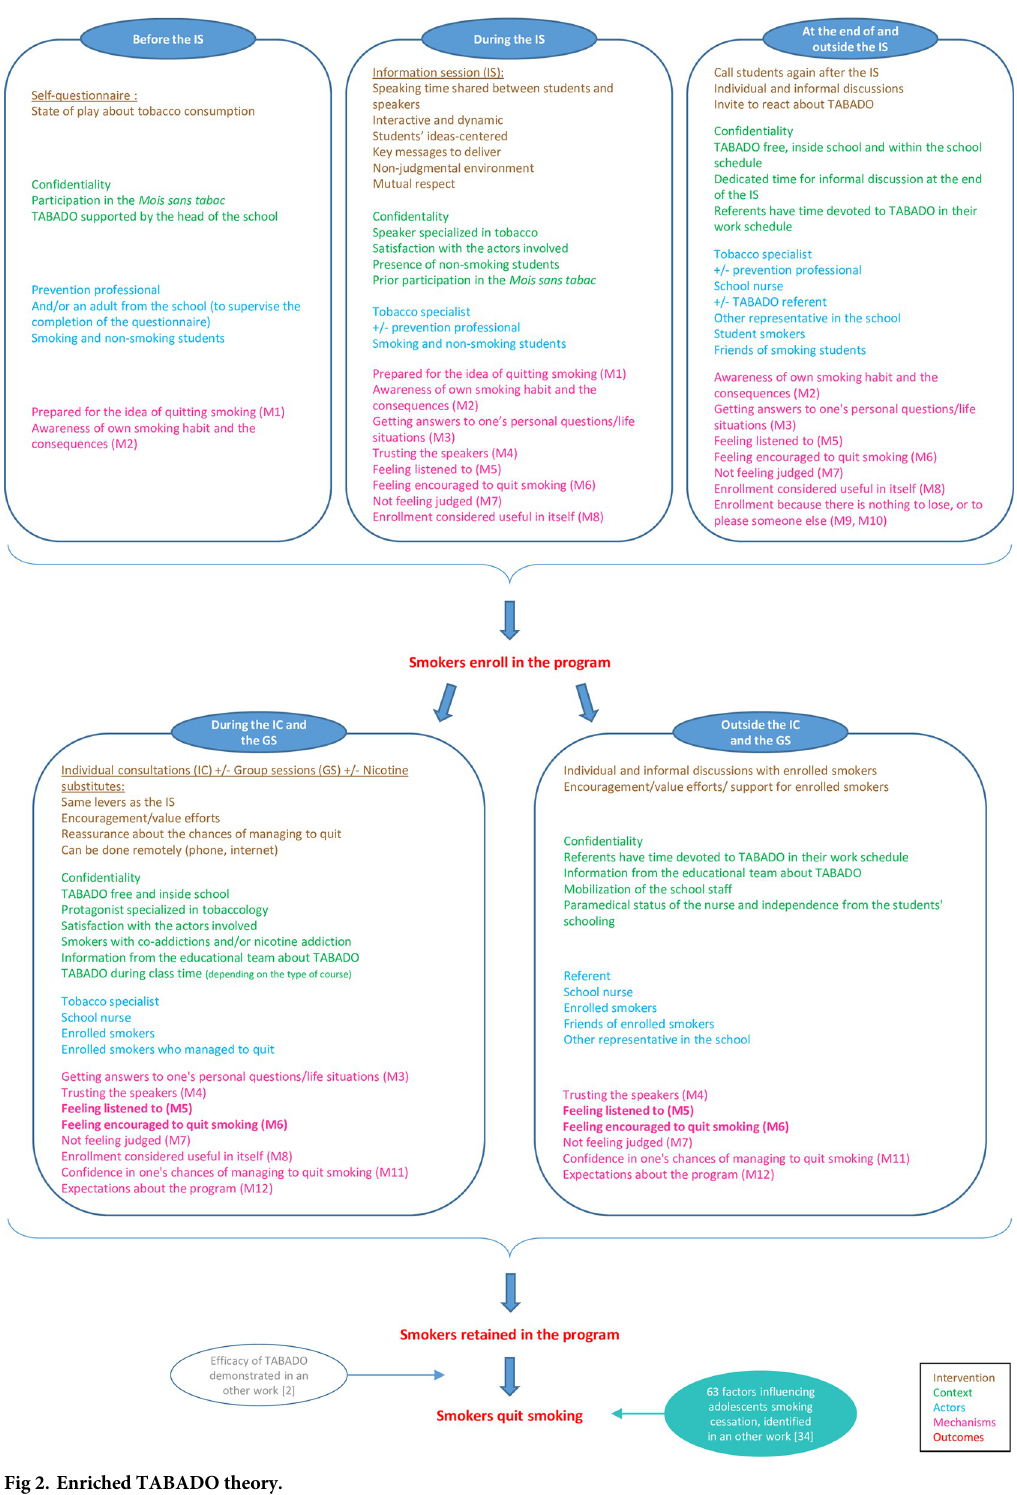
Fig 2. Enriched TABADO